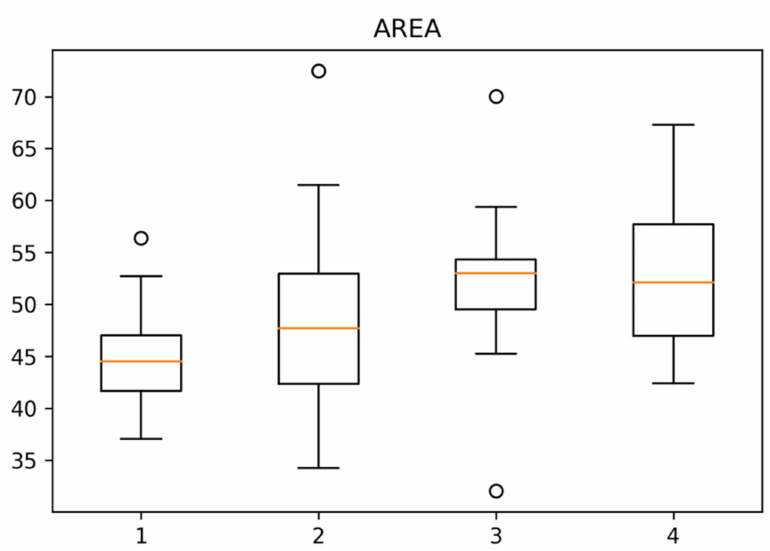
Figure 6. Box and Whisker plots for Area corresponding to four classes of tracheidogram: orange line—median; box—25% and 75% quartiles; whiskers—non-outlier minimum and maximum; circle—outlier.